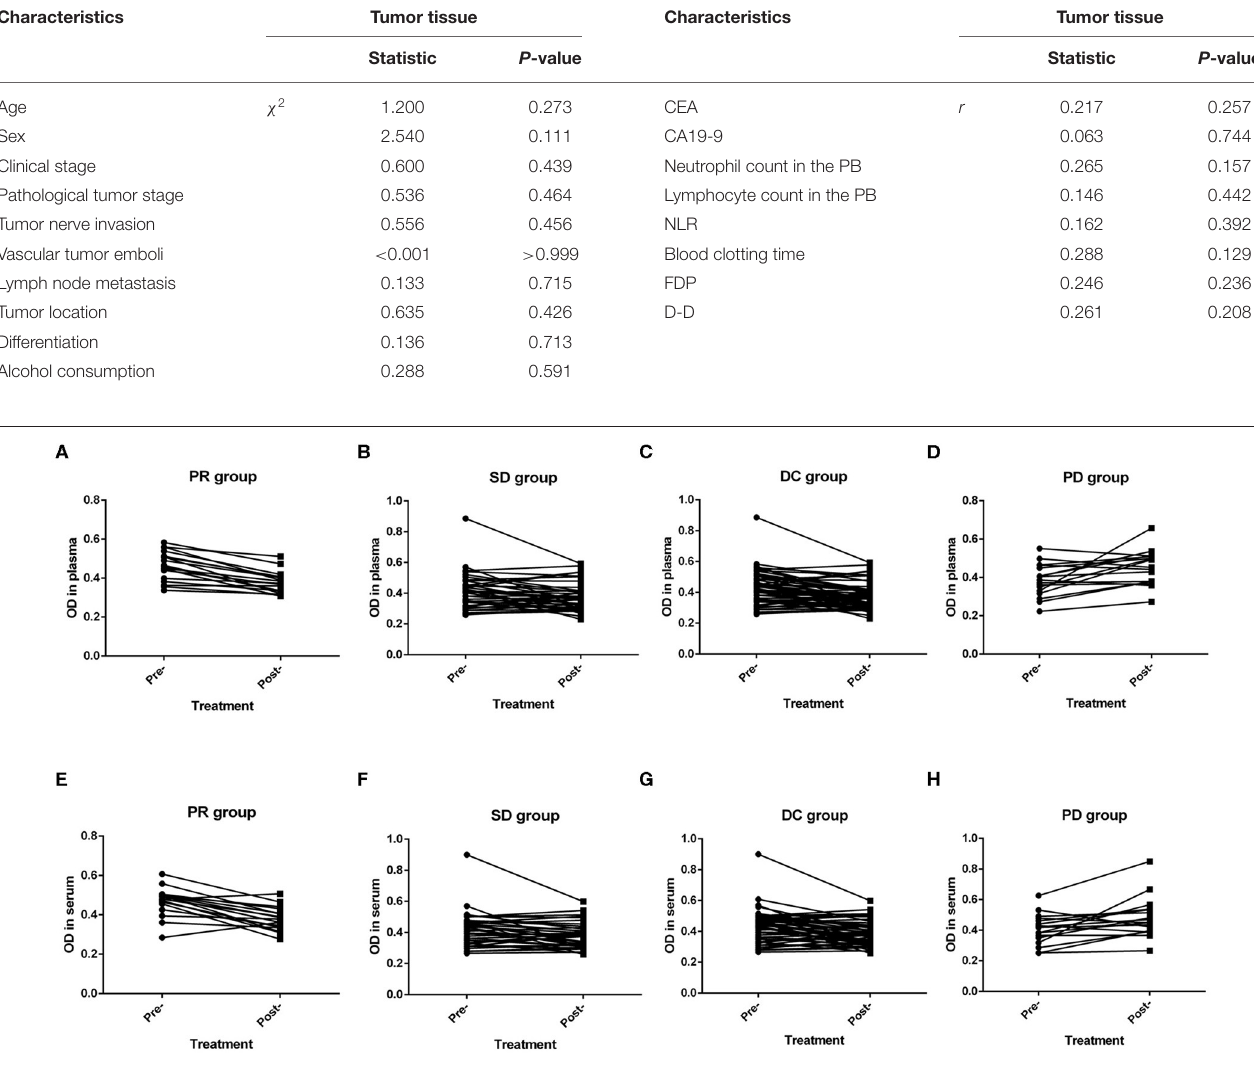
FIGURE 5 | Efficacy of advanced first-line treatment according to the levels of neutrophil extracellular traps (NETs) in the peripheral blood (PB) of patients with gastric cancer (GC). (A,E) The levels of NETs before treatment were significantly higher than those after treatment in both the plasma ( P < 0.001; A ) and the serum ( P < 0.001; E ) in the partial response (PR) group. (B,F) The levels of NETs before treatment were significantly higher than those after treatment in both the plasma ( P = 0.047; B ) and the serum ( P = 0.019; F ) in the stable disease (SD) group. (C,G) The levels of NETs before treatment were significantly higher than those after treatment in both the plasma ( P < 0.001; C ) and the serum ( P < 0.001; G ) in the disease control (DC) group. (D,H) The levels of NETs before treatment were significantly lower than those after treatment in both the plasma ( P = 0.008; D ) and the serum ( P = 0.009; H ) in the progressive disease (PD)